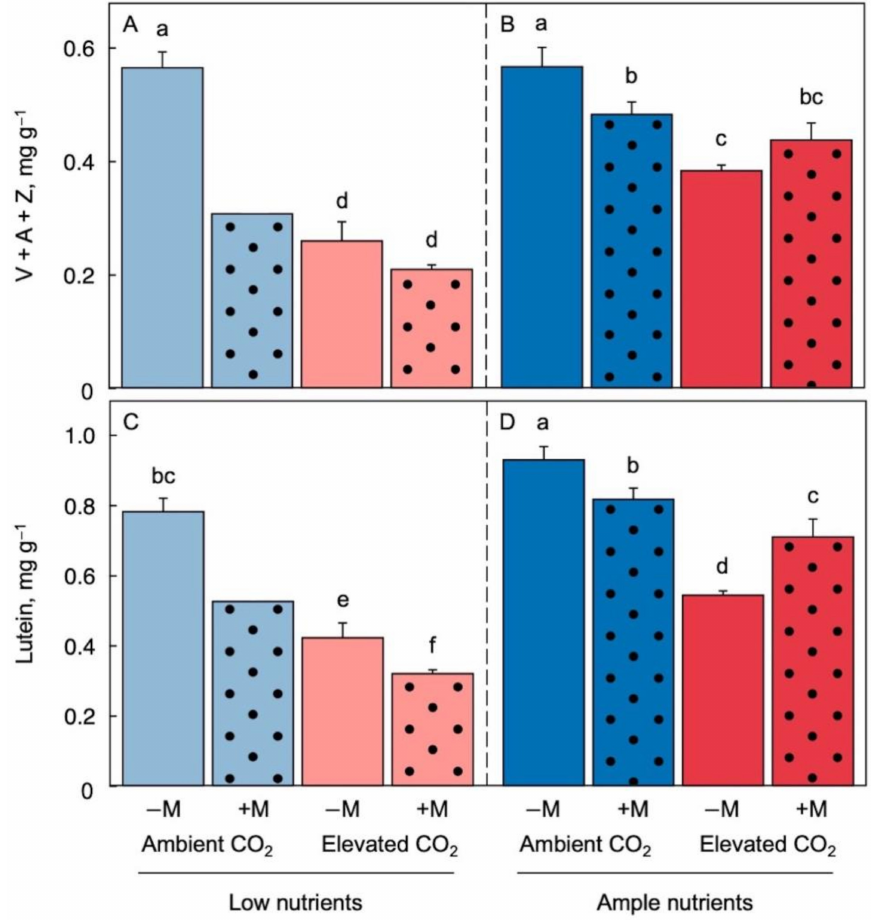
Figure 5. Ratios of the three carotenoids of the xanthophyll cycle to biomass under low ( A ) and ample ( B ) nutrients as well as lutein to biomass under low ( C ) and ample ( D ) nutrients for Lemna minor grown in 1/20 (light blue or light red) or 1/2 strength (dark blue or red) Schenk & Hildebrandt medium and either ambient (blue) or elevated (red) CO 2 levels. Bars with solid fill represent groups that were not inoculated ( − M) compared to bars with dotted fill that were inoculated (+M). A, antheraxanthin; V, violaxanthin; Z, zeaxanthin. Mean values ± standard deviations; n = 3 under all conditions except for n = 2 in the treatment of inoculated fronds in ambient CO 2 and low nutrients. Different lower-case letters represent significant differences at p <